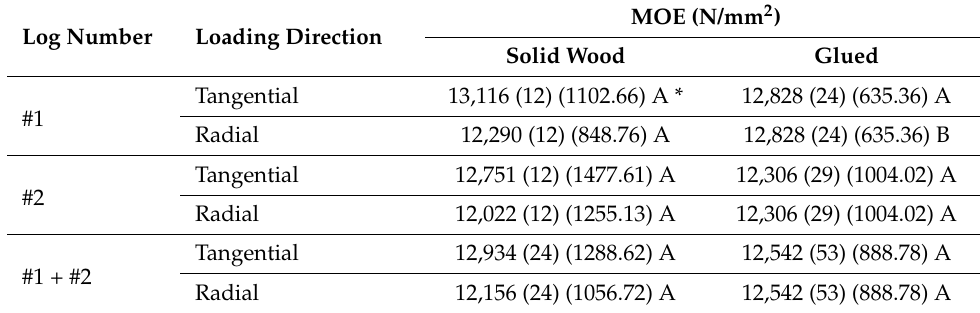
Table 7. Summary of mean values of modulus of elasticity